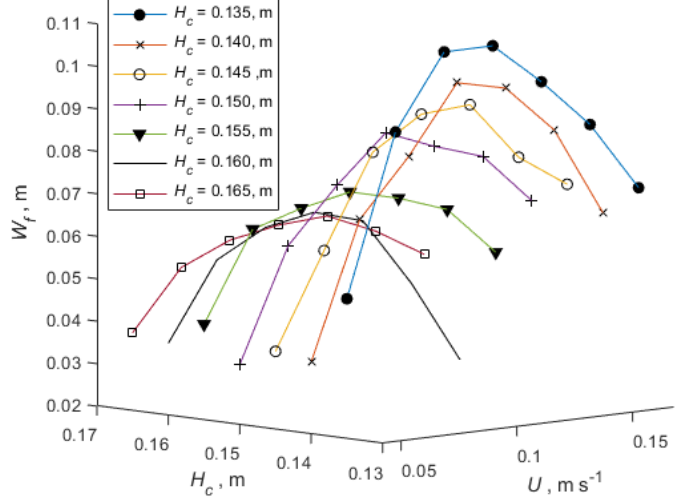
Figure 8. Variation of W f with U and H c .